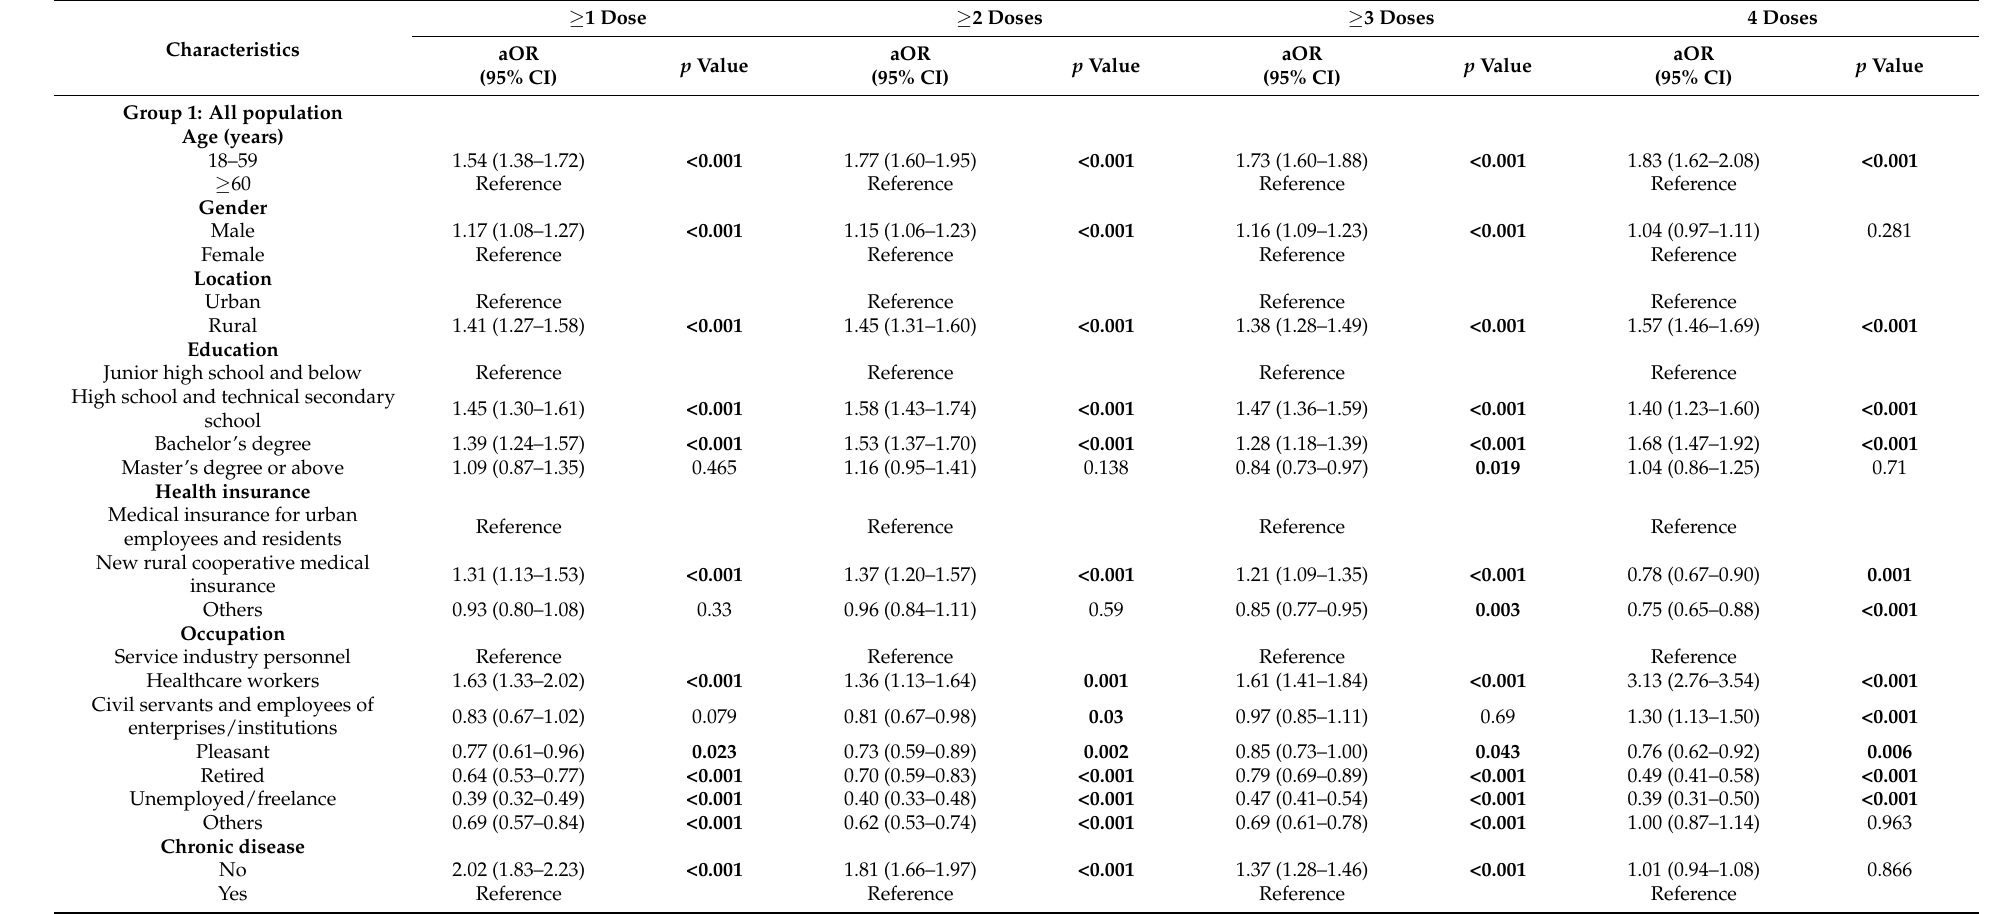
Table 3. Demographic determinants associated with the COVID-19 vaccination coverage rates among all populations and people aged ≥ 60 years